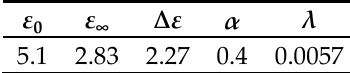
Table 1. Parameters in Equation (10) for a PS/PANI-based ER fluid. (Reprinted from [128], Copyright The Royal Society of Chemistry, 2015).